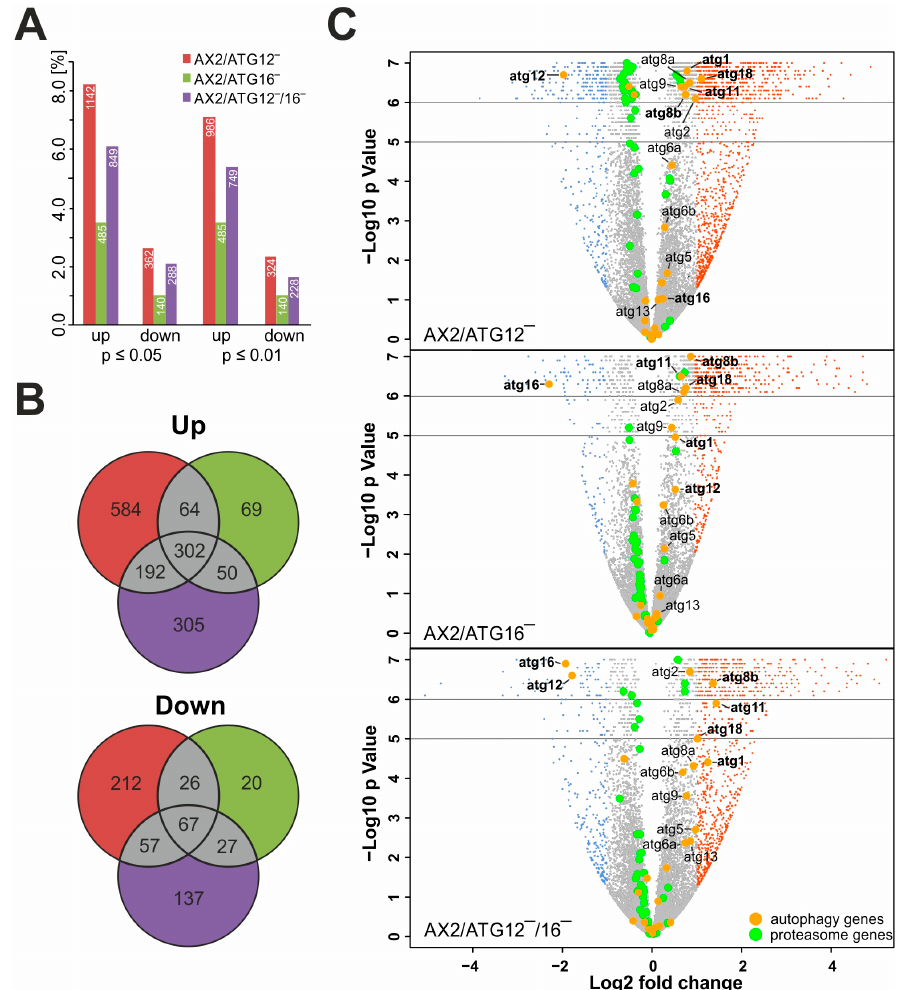
Figure 4. Differentially regulated genes in comparisons of AX2 with ATG12 − , ATG16 − , and ATG12 − /16 − strains. ( A ) Percentage of up- and down-regulated genes in dependence of different thresholds for fold change (FC ≥ 2.0, ≤ 0.5) and p -value ( p ≤ 0.05, ≤ 0.01) are shown. RNA was